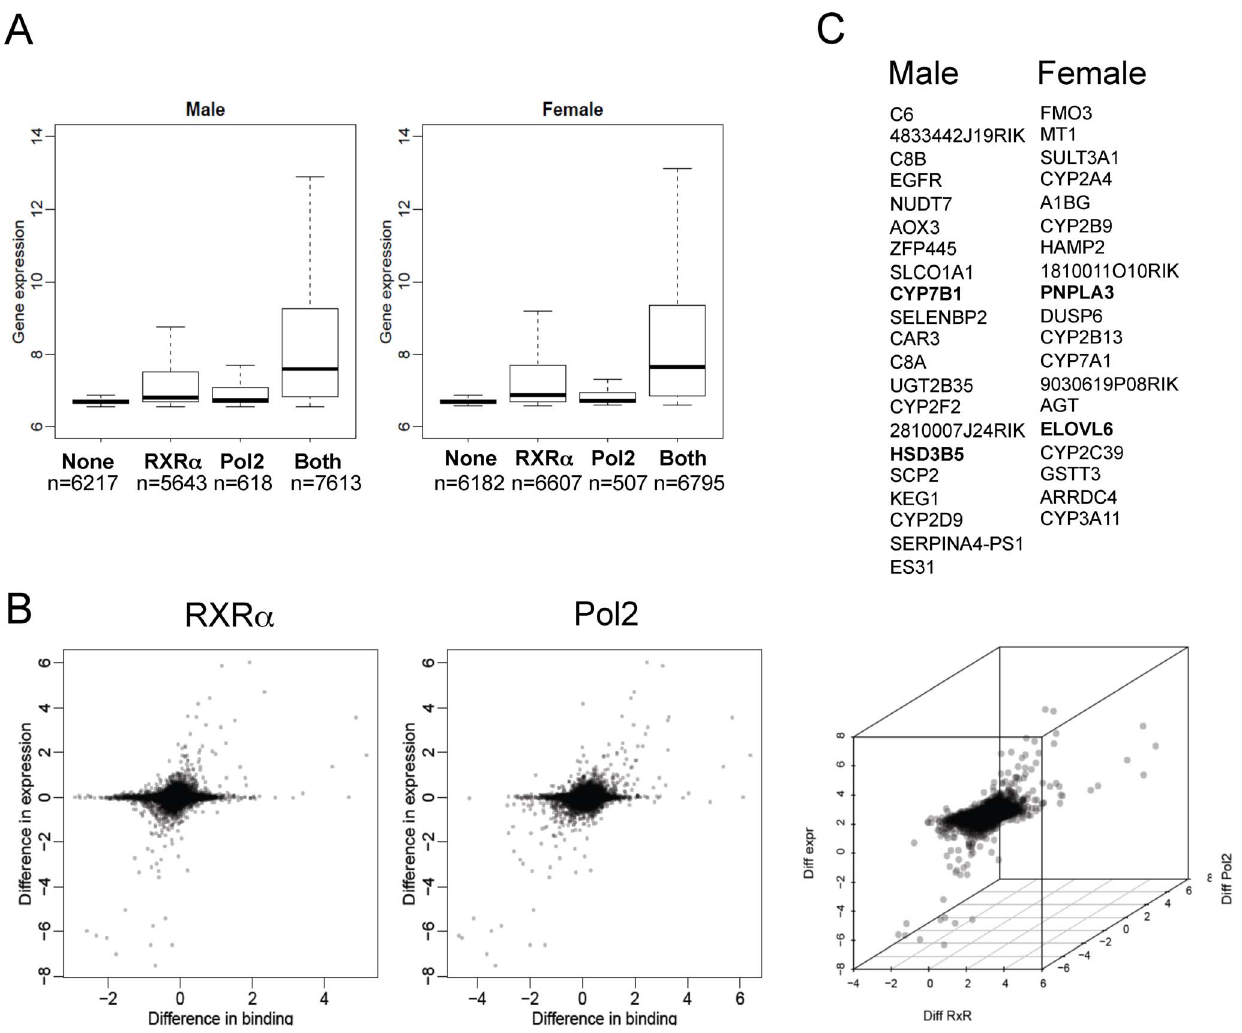
Figure 5. Correlation of gender differential RXR a , Pol2 and RNA expression levels. A) Correlation of RXR a and Pol2 binding with gene expression levels. B) Scatterplot representation of gender differential RXR a binding with gender differential gene expression on the left-hand side, and scatterplot representation of gender differential Pol2 binding with gender differential gene expression on the right-hand side. C) Genes with a gender specific positive correlation between RXR a binding Pol2 binding and changes in RNA levels (see also Fig. S4A–B and Table S6A–H in File S1).